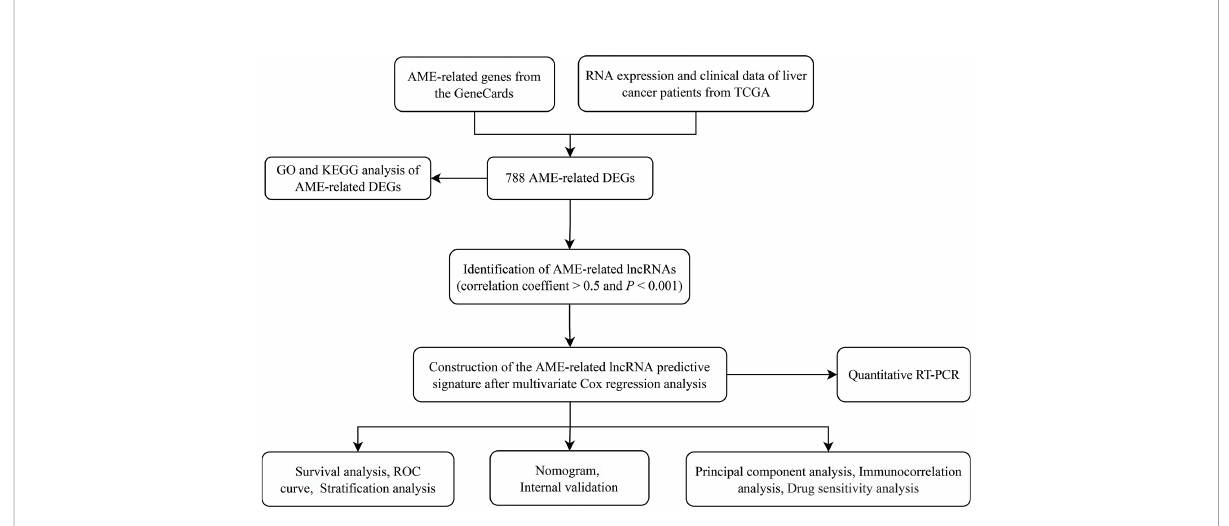
FIGURE 1 The fl owchart of our research. TCGA, The Cancer Genome Atlas; DFS, disease-free survival; DEGs, differentially expressed genes; GO, Gene Ontology; KEGG, Kyoto Encyclopedia of Genes and Genomes; lncRNAs, long noncoding